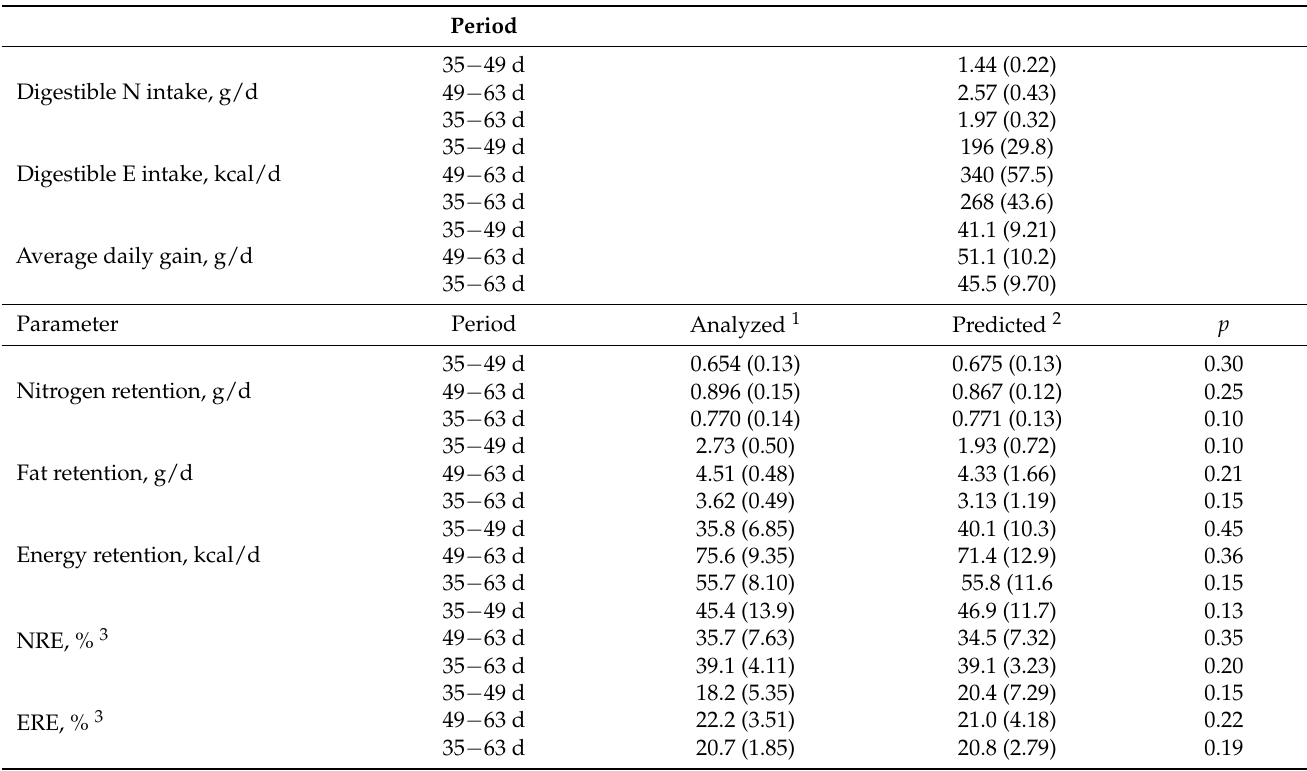
Table 7. Comparison between analyzed and predicted nitrogen, fat and energy retention and